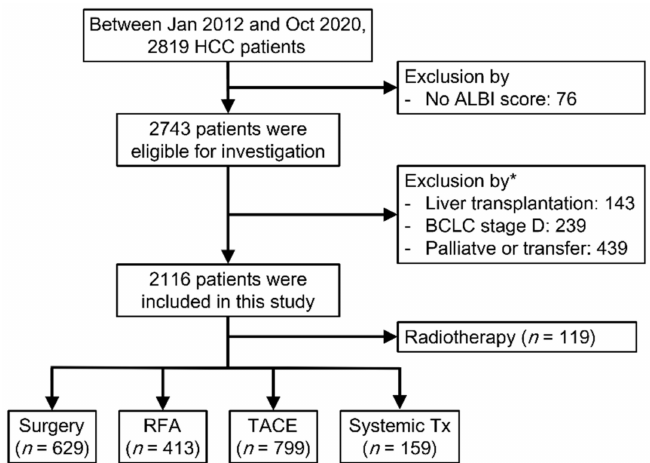
Figure 1. Flowchart of patient enrollment and stratification. ALBI, albumin–bilirubin; BCLC, Barcelona Clinic Liver Cancer; HCC, hepatocellular carcinoma; RFA, radiofrequency ablation; TACE, transarterial chemoembolization. * Patients might have met more than one exclusion